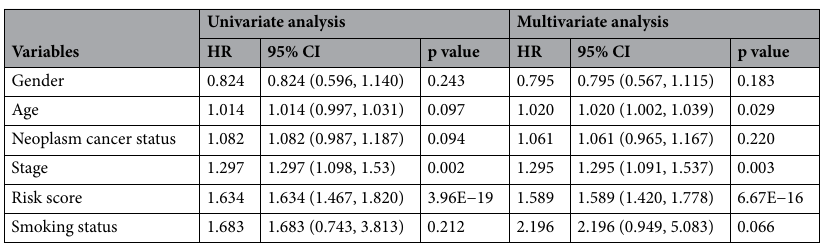
Table 2. Univariate and multivariate cox regression analyses of the prognosis-related factors.